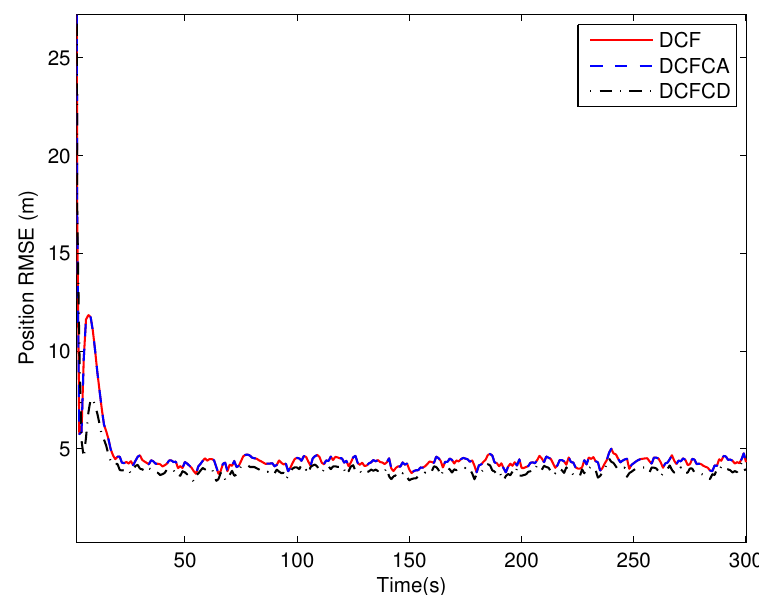
Figure 11. The position RMSE for different methods over time under white Gaussian noise.